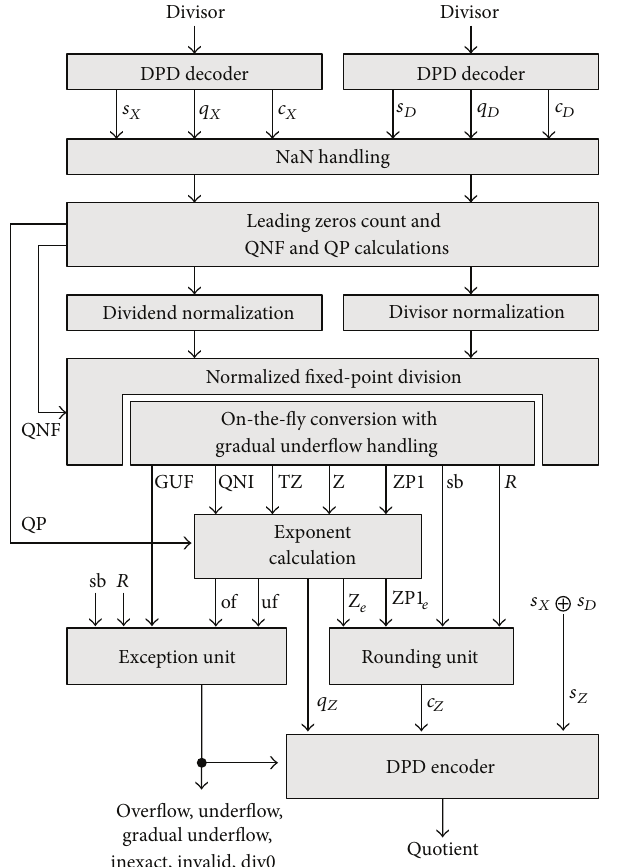
Figure 10: Block diagram of the floating-point divider.